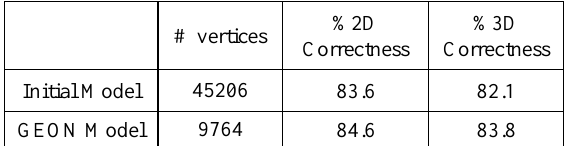
Table 1. 2D and 3D correctness of initial segmented and GEON- based model in the UCSD